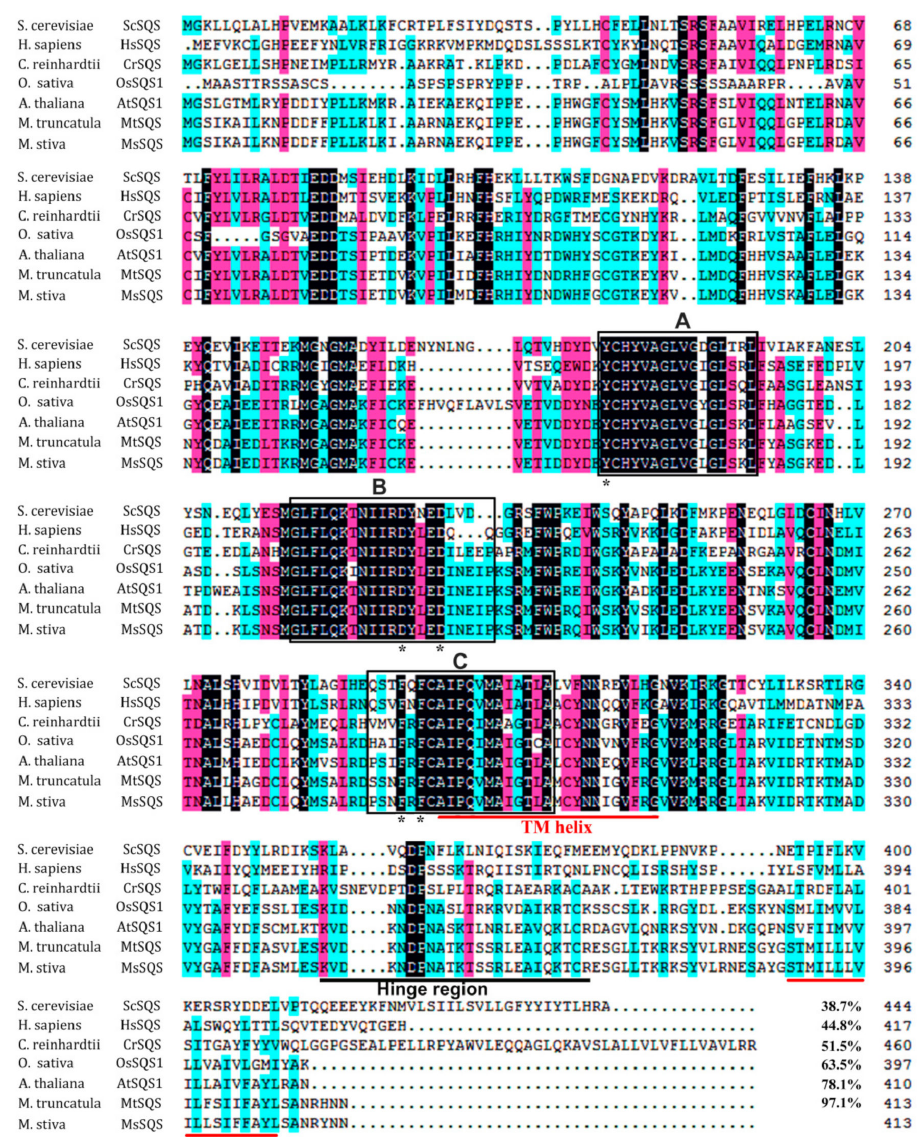
Figure 2. Sequence alignment of the representative squalene synthase proteins from the indicated species. Gene accession numbers: ACD03847.1 ( S. Cerevisiae ); AAP36671.1 ( H. sapiens ); Cr03g175250v5 ( C. reinhardtii ); Os07g0200700 ( O. sativa ); At4g34640 ( A. thaliana); Mt4g071520 ( M. truncatula ). Sequence was aligned using DNAMAN (Version 7) (Lynnon Corporation, Quebec, Canada). Homology level was highlighted by shading in color: black for 100%, pink for ≥ 75% and blue for ≥ 50% identity. Conserved segments (A, B and C) were boxed, the predicted transmembrane helix and the hinge region with low similarity to yeast was underlined in red and in black, respectively. An asterisk (*) indicates the conserved key residues in the three